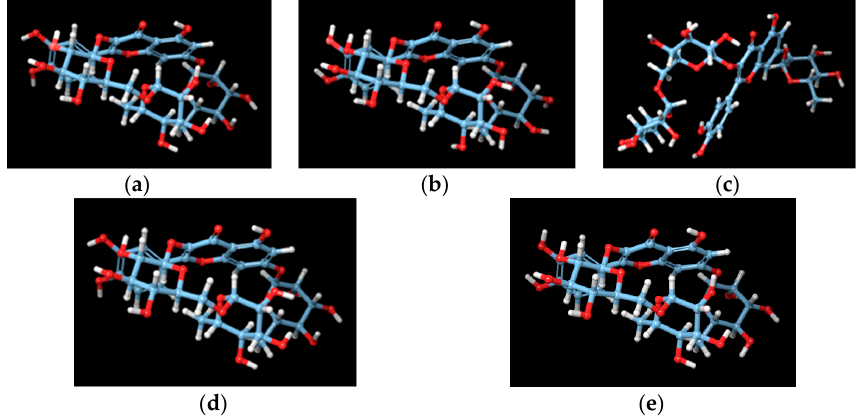
Figure 4. Five snapshots ( a – e ) from the 50-ns MD simulation of quercetin-3-rutinoside7-rhamnoside in DPPC bilayers. The four out of five 3D structures, ( a , b , d , e ), reveal internal wrapping of the molecule to keep the nonpolar carbohydrate chains from interaction with the alkyl chains of the bilayer.